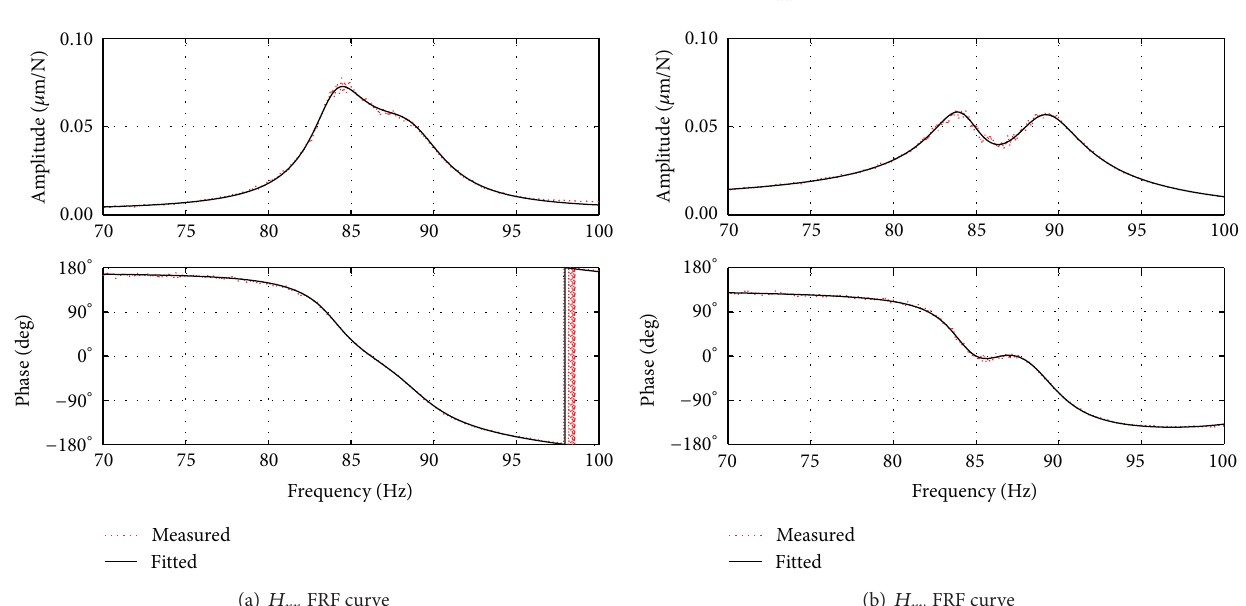
Figure 13: Test and fitted result based on MIMO